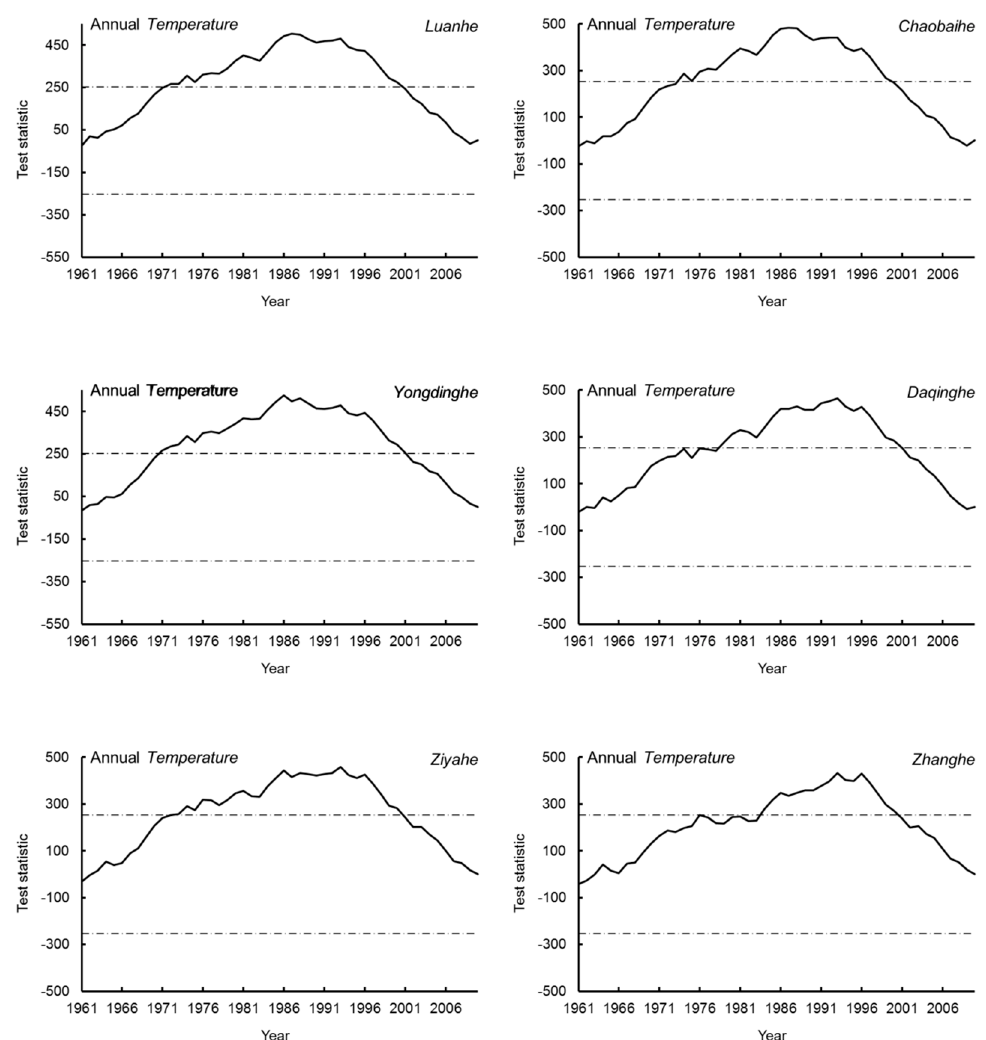
Figure 3. Detection results of the abrupt change point of air temperature in the six sub-basins of the Haihe River Basin.